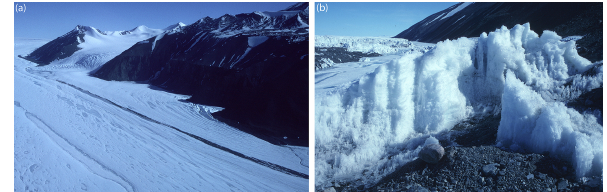
Figure 3. Longitudinal ice-surface structures, demonstrably folia- tion, at the western margin of the Lambert Glacier–Amery Ice Shelf system, East Antarctica, adjacent to Fisher Massif. (a) Oblique aerial photograph illustrating longitudinal foliation parallel to a medial moraine, defining a flow-unit boundary between the main glacier and a local tributary, and showing the close relationship be- tween supraglacial meltwater channels and ponds. (b) Ground view of near-vertical longitudinal foliation, defined by differential weath- ering, at the edge of the glacier system. Photographs: M. J. Ham- brey.